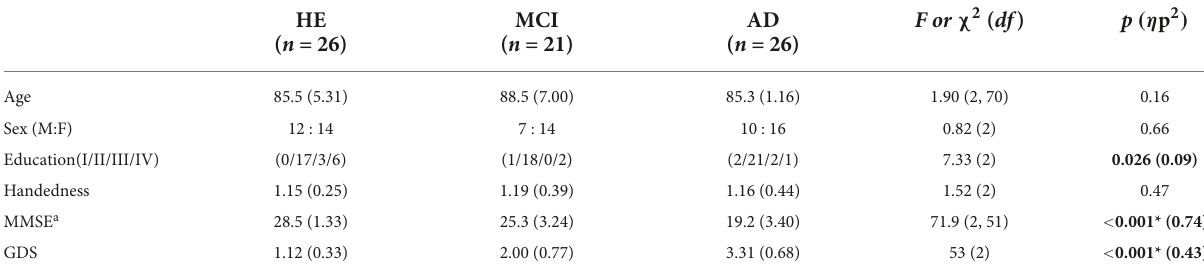
TABLE 1 Characteristics of the groups studied in the cross-sectional study.